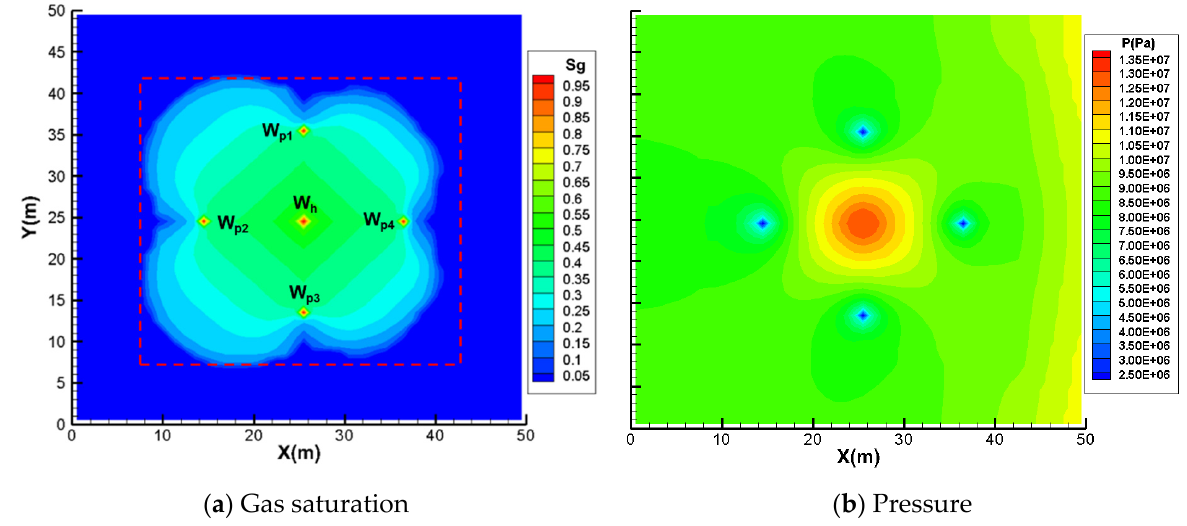
Figure 3. Gas saturation and pressure nephograms after gas injection for 6 months.